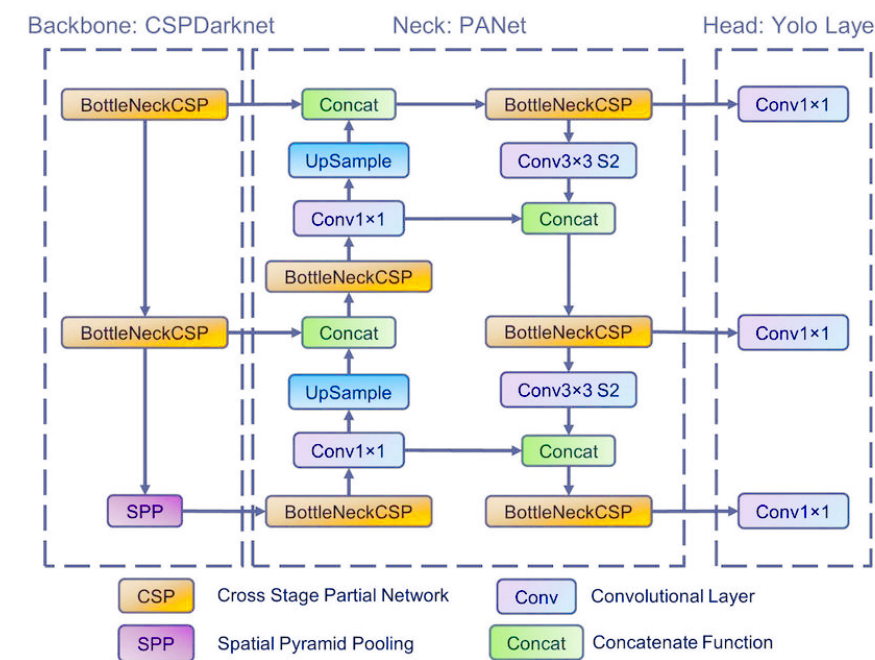
Figure 5. YOLOv5 architecture [44].